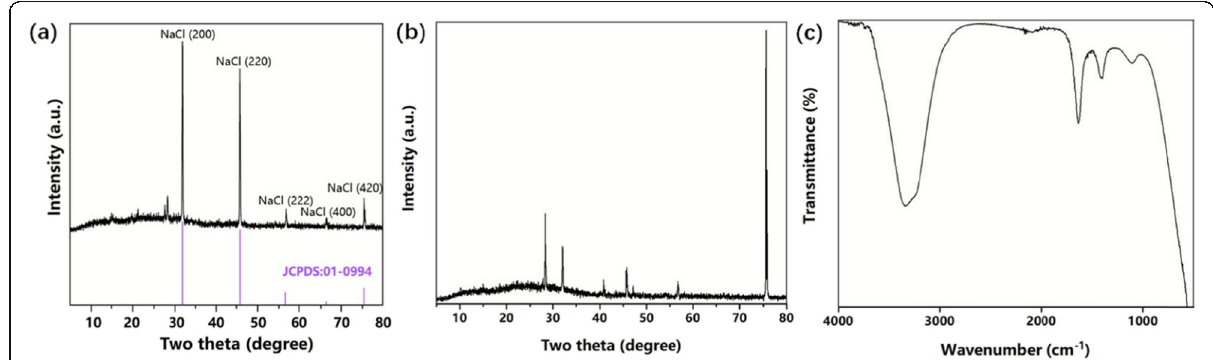
Fig. 1 The XRD patterns of electrodeposition solution which were heated and dried with an alcohol lamp ( a ) and with an oven (60 °C) ( b ). The FTIR pattern of electrodeposition solution ( c ) after